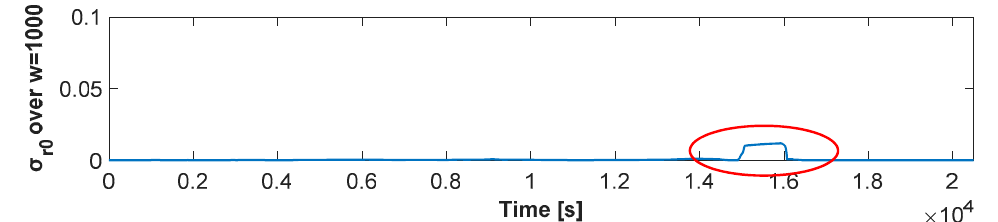
Figure 8. Evolution of σ r0 for a flow rate of 1 L/h. Table 3. Mean r 0 and Maximum Standard Deviation calculated on a sliding window of r 0 of size w = 1000. Multijet Water